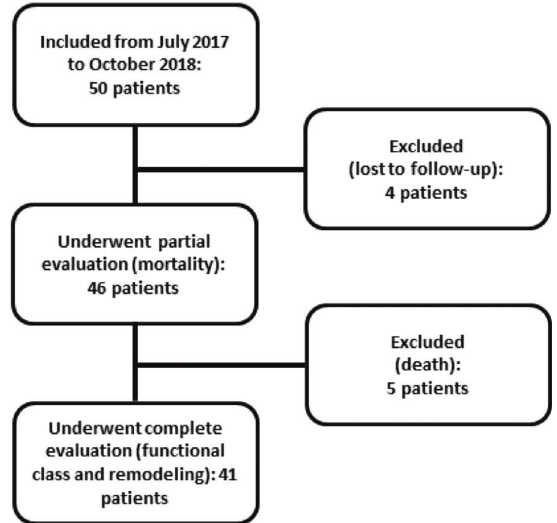
Figure 1 - Flowchart of patient